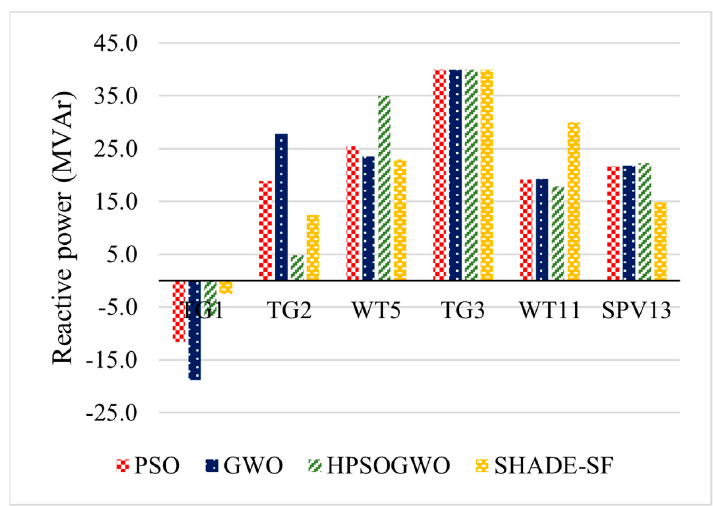
Figure 16. Generators reactive powers comparison (Case 3).